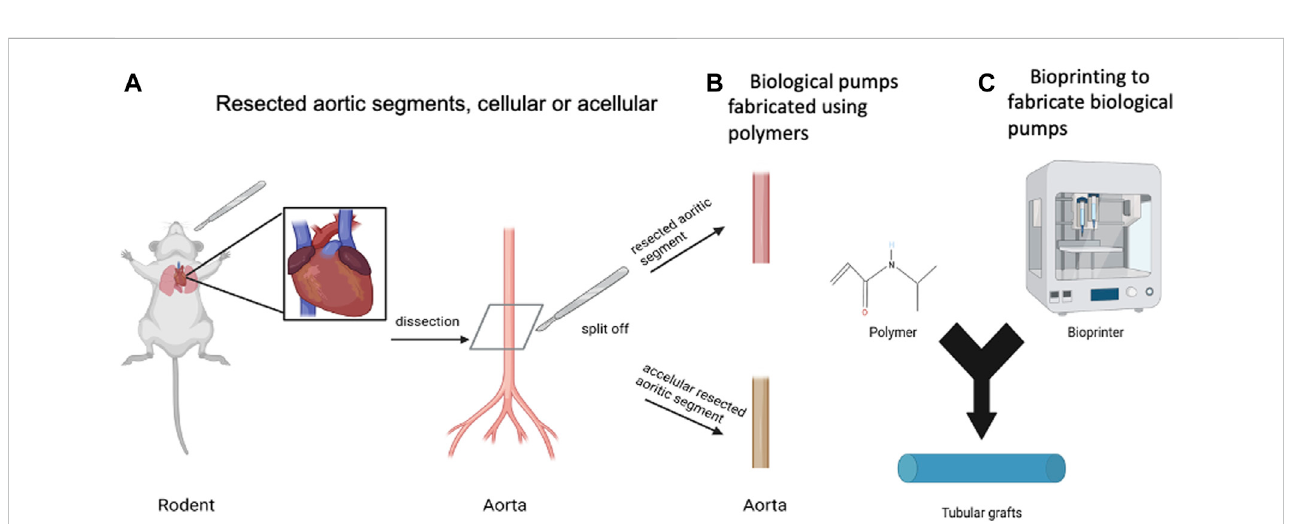
FIGURE 3 Biomaterials for Biological Pumps — (A) Resected aortic segments, cellular or acellular. (B) Biological pumps fabricated using polymers. (C) Bioprinting to fabricate biological pumps. Created with BioRender.com.